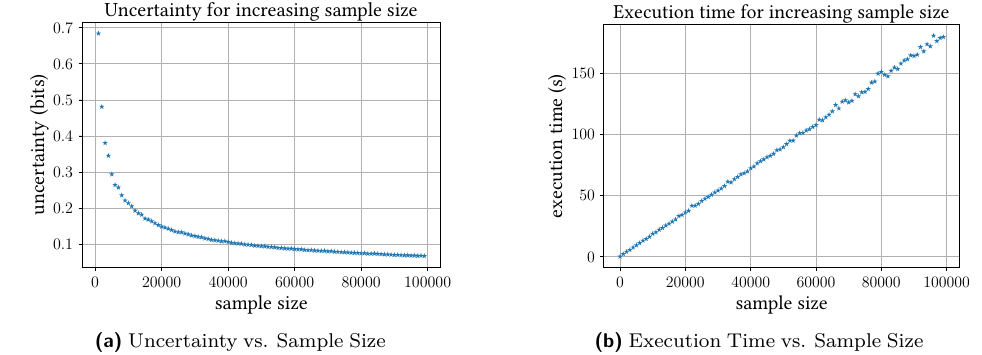
Figure 4: AES-256. Uncertainty (a) and execution time (b) for increasing sample size. tacks, each for 6 different values of the noise variance, for a total of 60 cases. For each case, we run the Histogram Enumeration method (with merge =2) increasing the number of bins until the uncertainty value becomes lower then 1 ( HEL Uncertainty < 1). Then, we run MCRank for increasing samplesize , until the uncertainty is lower (i.e., better) than that of the Histogram Enumeration method ( MCRank Uncertainty < HEL Uncertainty ) for 10 consecutive times. MCRank is orders of magnitude faster than the Histogram Enumeration method, for comparable